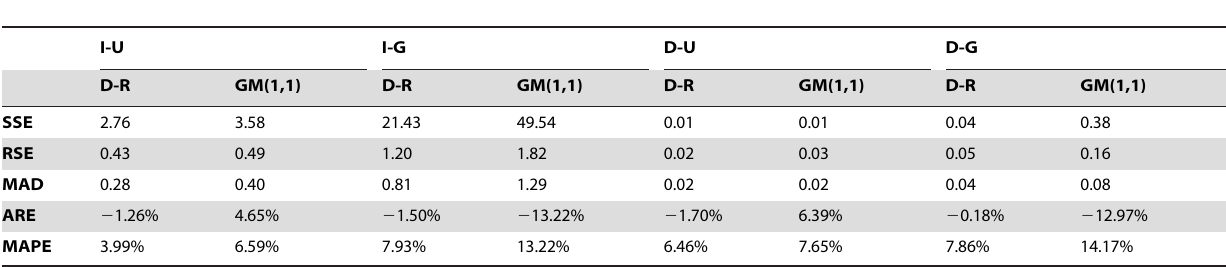
Table 3. Calculation of key accuracy indexes spanning 1994–2009 evaluating the predictive quality of the D-R and GM(1,1)